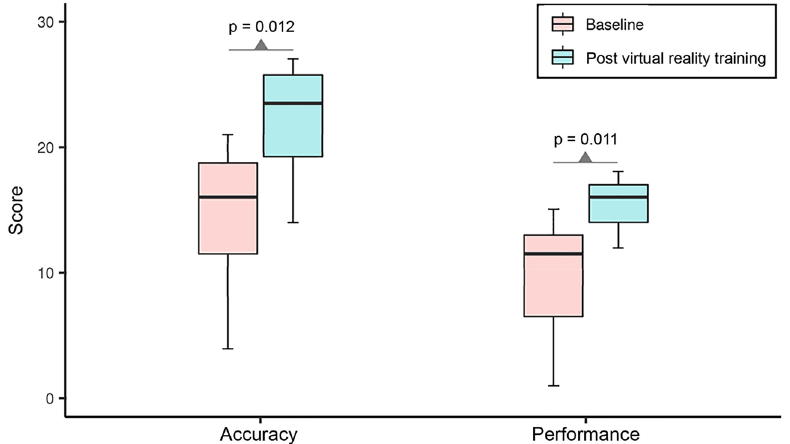
Figure 3. Comparisons of accuracy and performance scores before and after virtual reality training. After 30 sessions of virtual reality training for 2 weeks, participants’ accuracy and performance scores significantly improved (total accuracy and performance scores are 30 and 20 points, respectively; the paired t -test was used to compare changes in